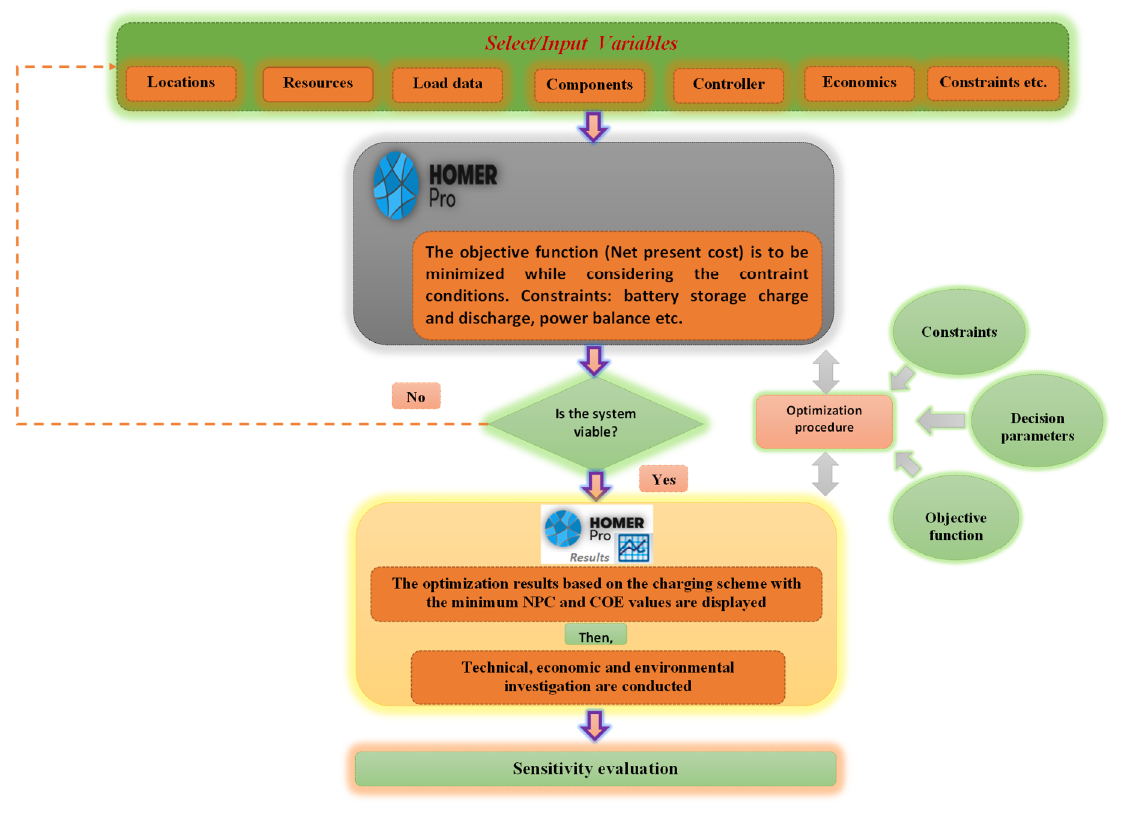
Figure 4. Assessment flowchart and optimization process utilized in the HOMER Pro ® microgrid tool.